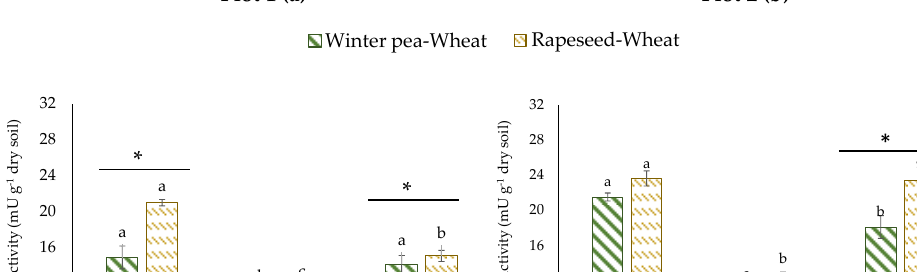
Figure 2. Total microbial communities, bacterial and fungal abundance in two crop succession (winter pea–wheat, rapeseed–wheat) at 3 sampling dates in the plot 1 ( a ) and plot 2 ( b ). Error bars on data points represent the standard errors of the mean of three replicates (n = 3). Letters indicate statistical significance between the 3 sampling dates and asterisks indicate statistical significance between the two successions (pea–wheat vs. rapeseed–wheat) at p < 0.05 according to Tukey’s test.